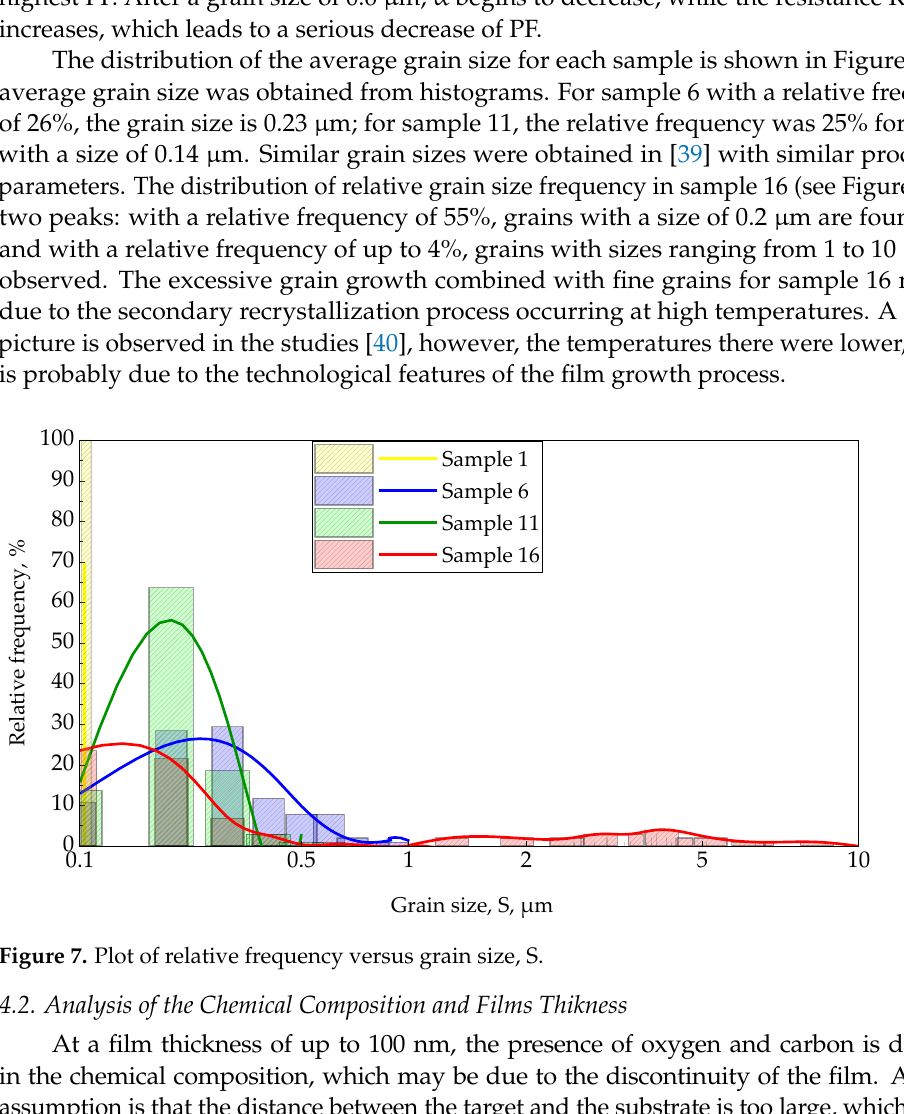
Figure 6. Plot of basic properties, α, R, PF, versus average grain size, S b .